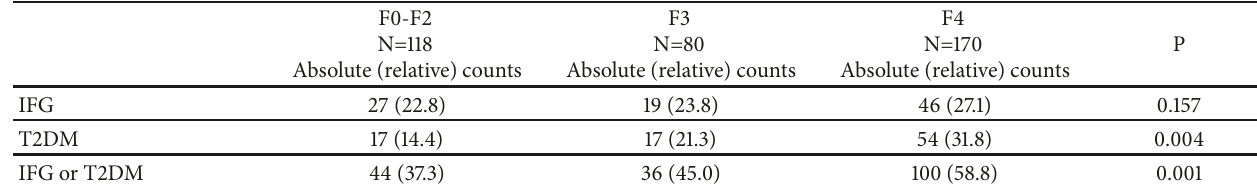
Table 3: Prevalence of impaired fasting glucose and type 2 DM by the degree of